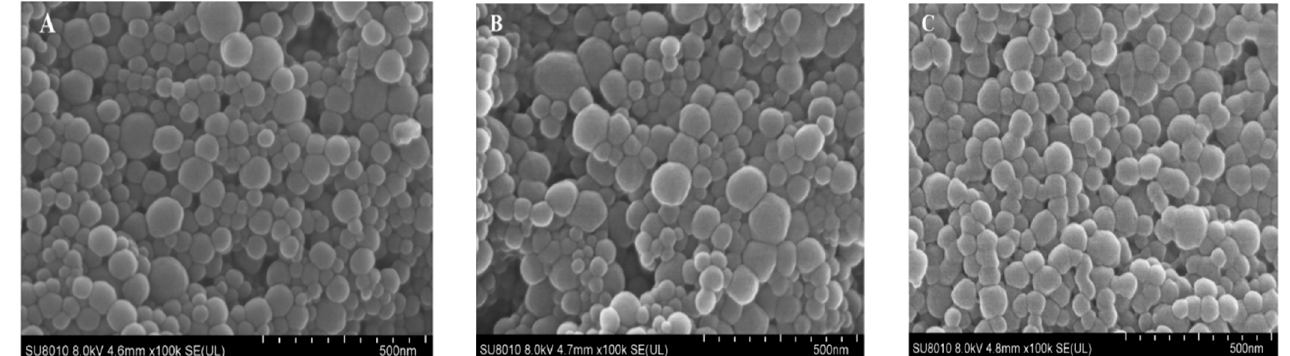
Figure 2. SEM images of quercetin-loaded hollow zein (qHZ, ( A )), zein-chitosan (qHZ-chi, ( B )) and zein-chitosan/pectin (qHZ-chi/pec, ( C )) particles. The concentrations of chitosan and pectin were 1 and 0.1 mg/mL, respectively.